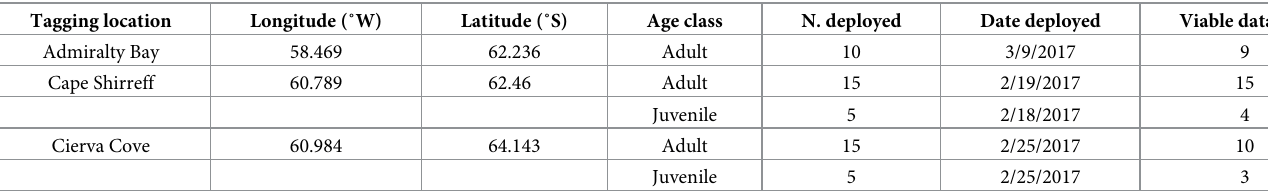
Viable data sets are those with � 7 d of